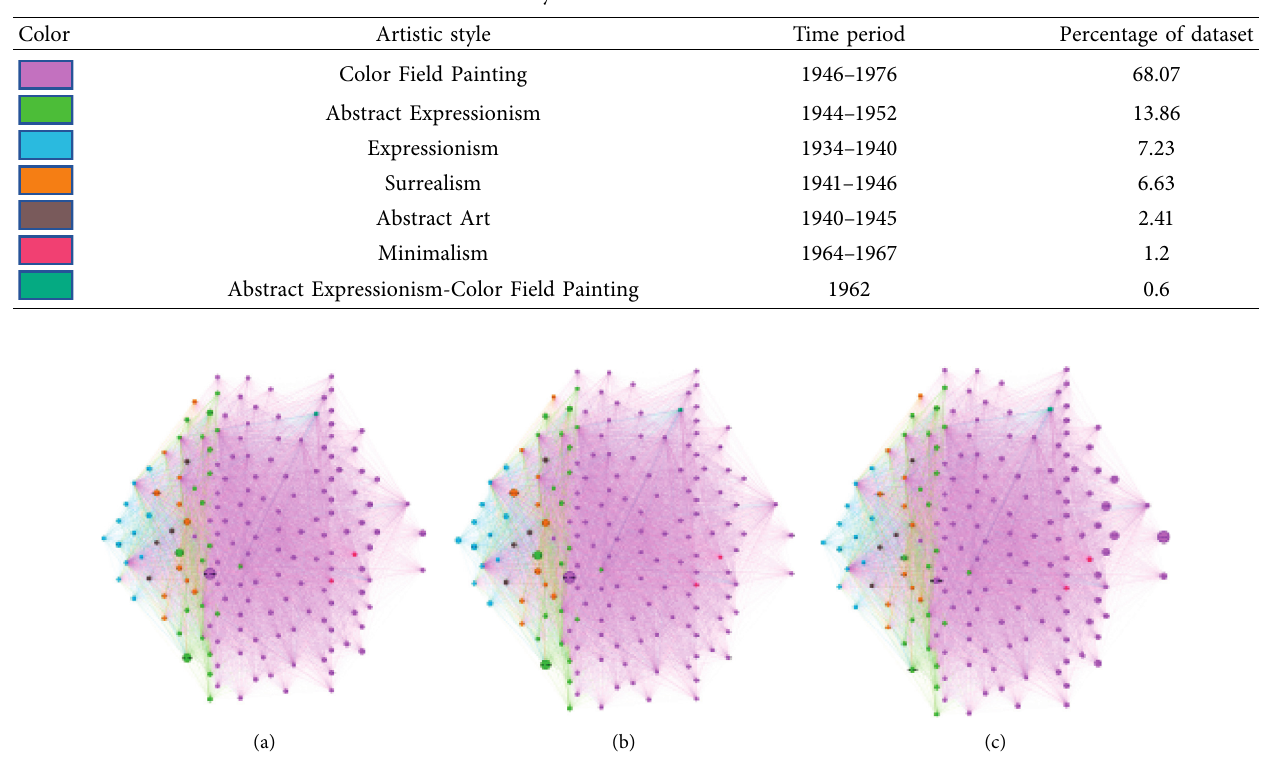
Figure 13: N network based on IR . 166 paintings colored by artistic style (see Table 3). (a) Creativity scores in terms of size of nodes. 3 5 (b) Combination of originality and influence by parameter β � 0 . 1. In this case, influence is given 90% of the weight in the calculation of the score. (c) Just as previous image, β � 0 . 9, originality is given 90% of the weight.